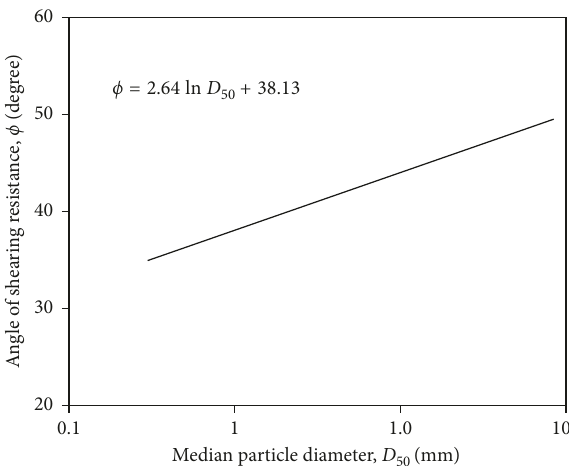
Figure 2: Correlation between the median particle diameter and the angle of shearing resistance [32].